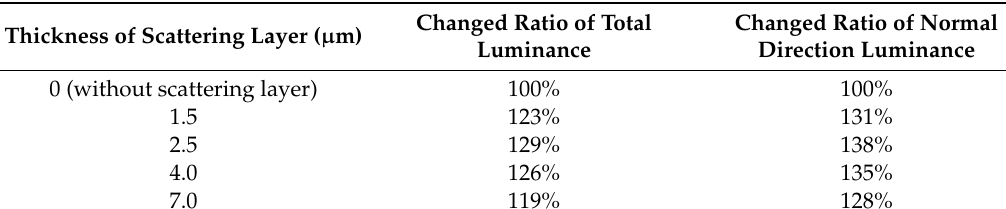
Table 3. Ratio of the luminance of OLED devices with the YSZ scattering layer to the luminance of the reference OLED without the scattering layer, for various layer thickness.